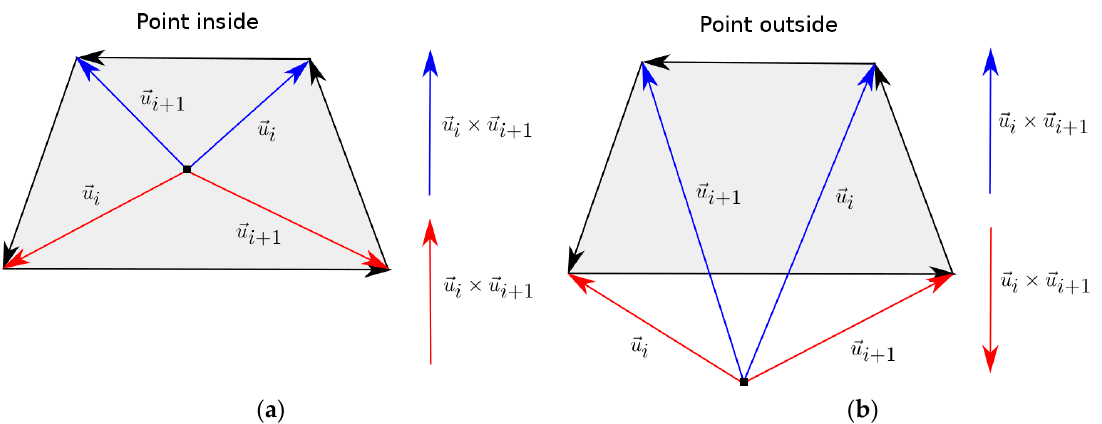
Figure 4. ( a ) Point inside the polygon: The cross product between adjacent vectors going from the intersection point to the successive polygon vertices point always in the same direction. ( b ) Point outside the polygon: the cross product between adjacent vectors going from the intersection point to the successive polygon vertices point in opposite directions. In both cases, the polygon must be flat, convex, and the intersection point must be in the polygon plane.